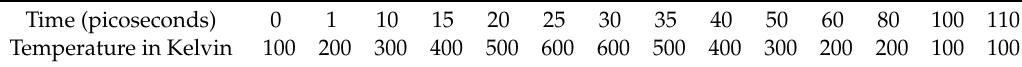
Table 2. Cycles of simulated annealing used in GROMACS